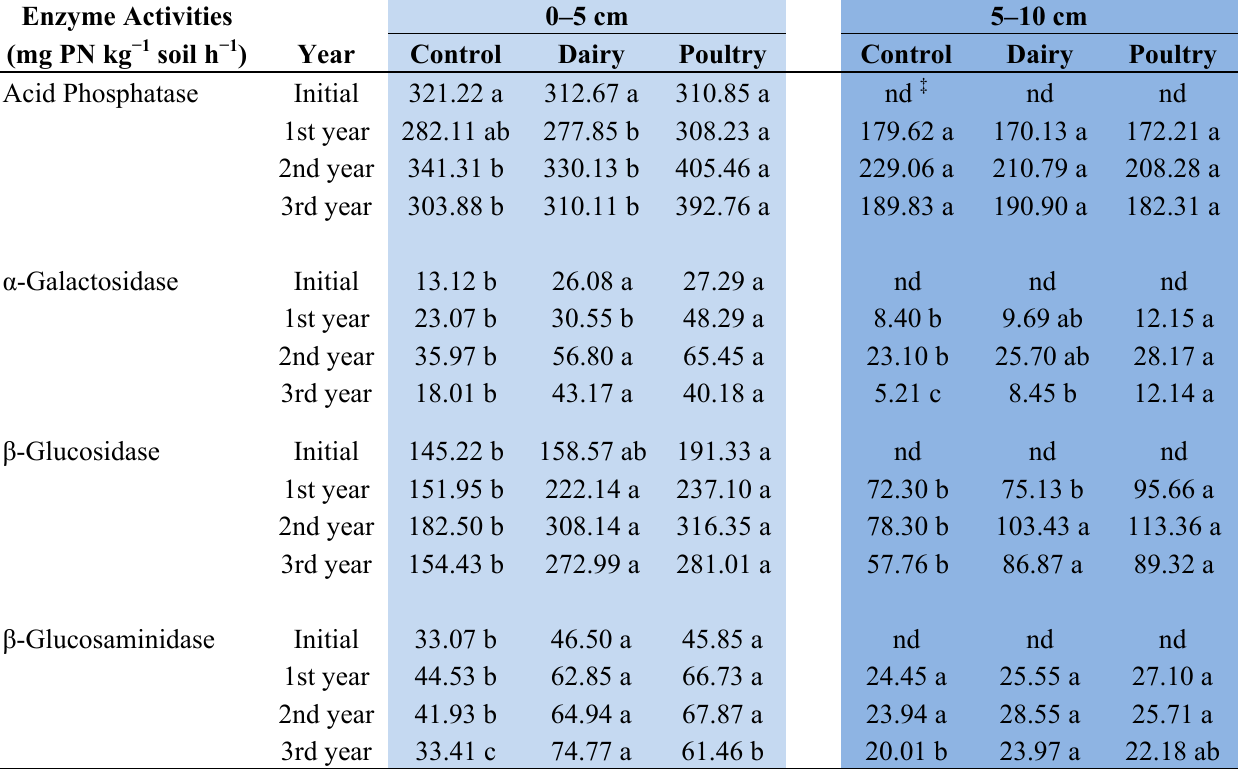
Table 4. Enzyme activities in a silt loam as a function of different manure types in KY †